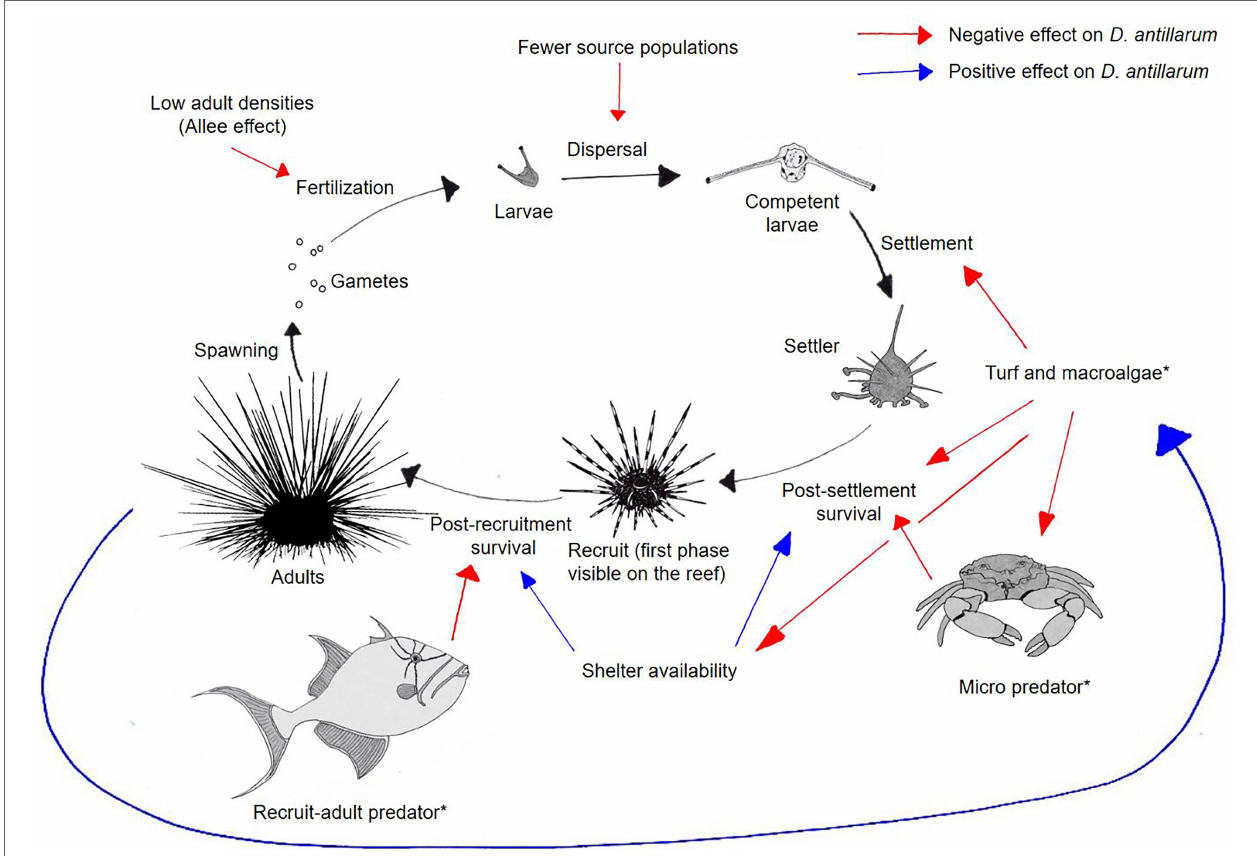
FIGURE 7 | Life cycle of D. antillarum (black arrows) and factors constraining (red arrows) or enhancing (blue arrows) D. antillarum population development. Factors with an asterisk (*) likely affected D. antillarum recruitment in the present